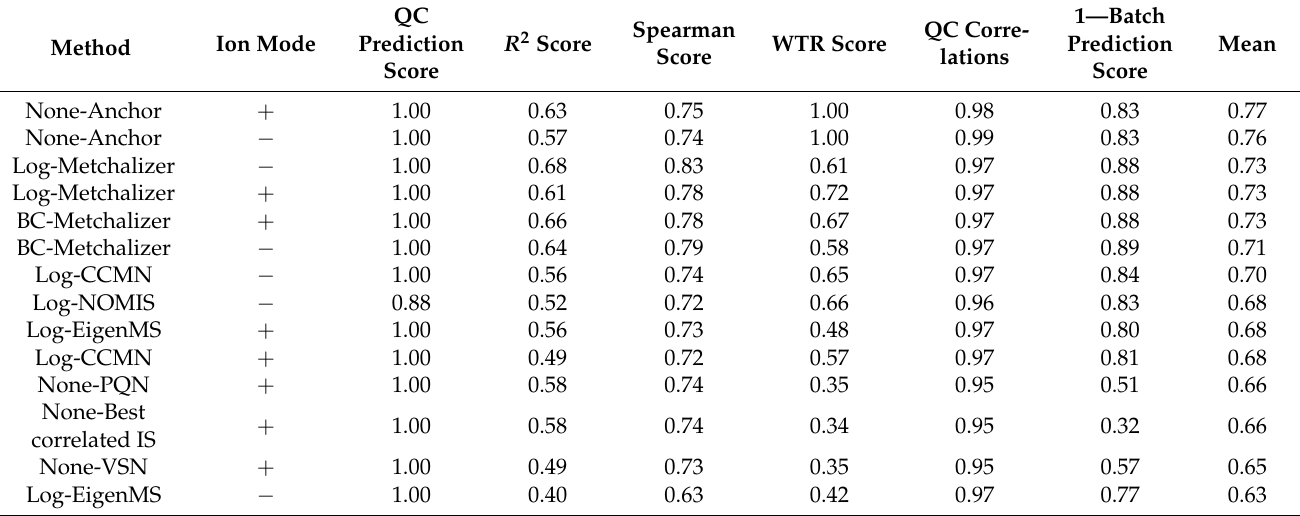
Table A2. Median scores for six metrics per normalization method and ion mode. The last column is the average of the former columns. Note, that we modified the batch prediction score such that higher values correspond with improved normalization